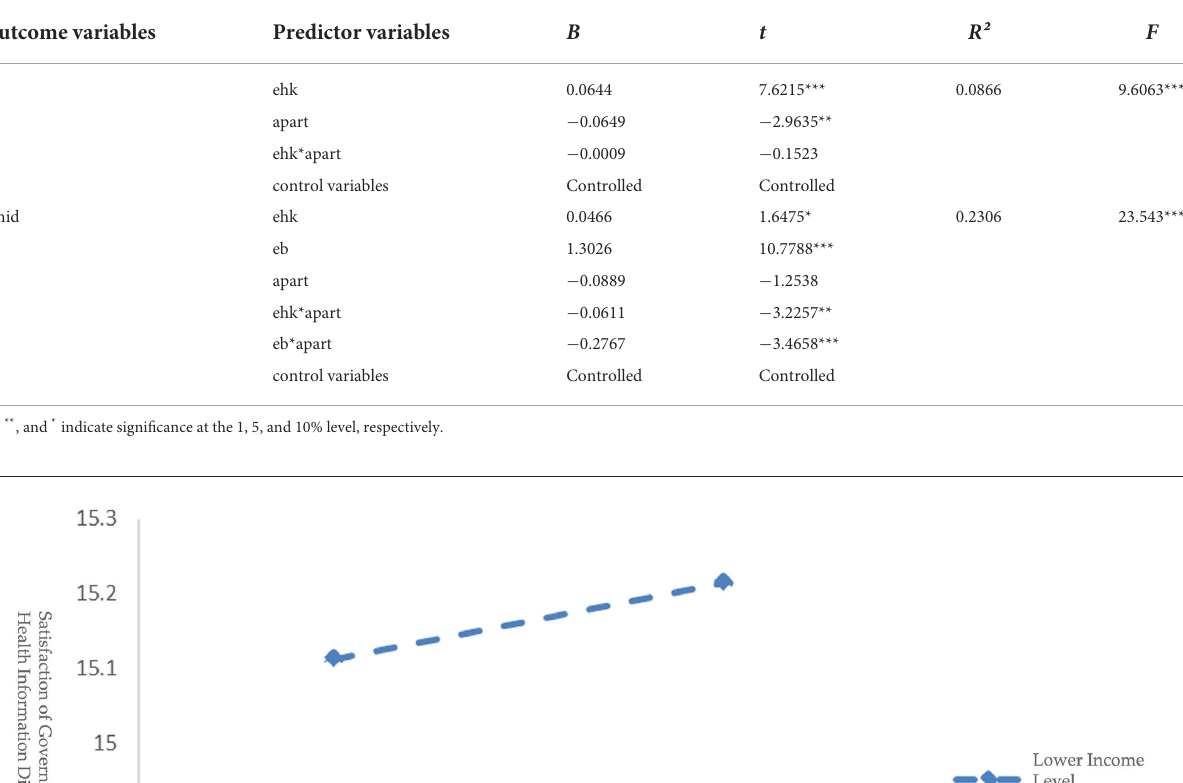
TABLE 6 Moderated mediation results.